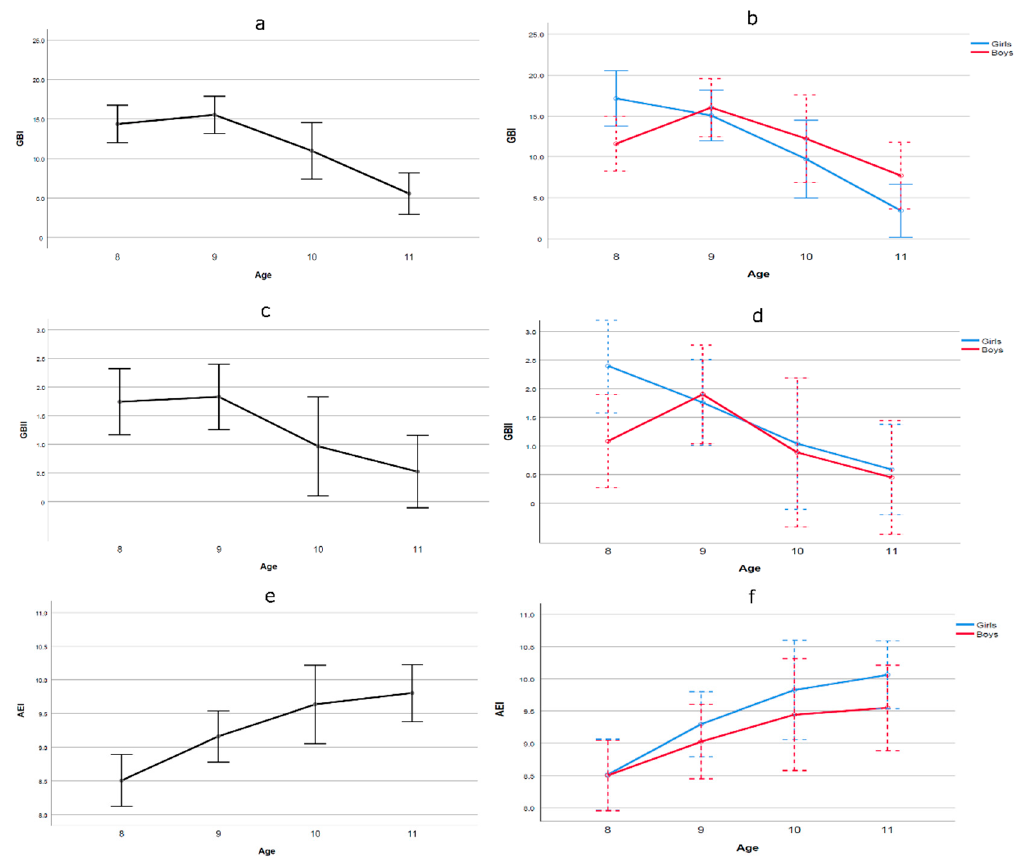
Figure 1. Age and age by gender on global bullying index (GBI, figures a and b ), global bullying intensity index (GBII, figures c and d ) and ability emotional intelligence (AEI, figures e and f ). Error bars 95% CI.